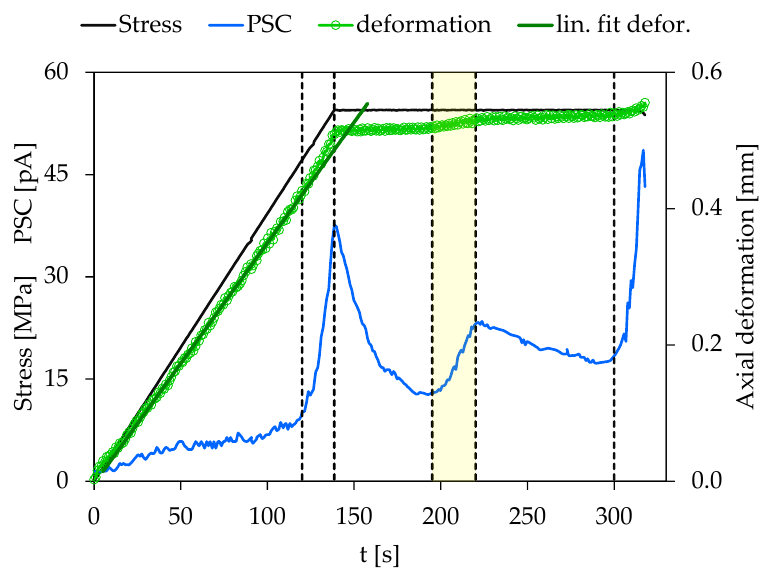
Figure 2. The PSC, the stress and the axial deformation variations, depicted with respect to time.